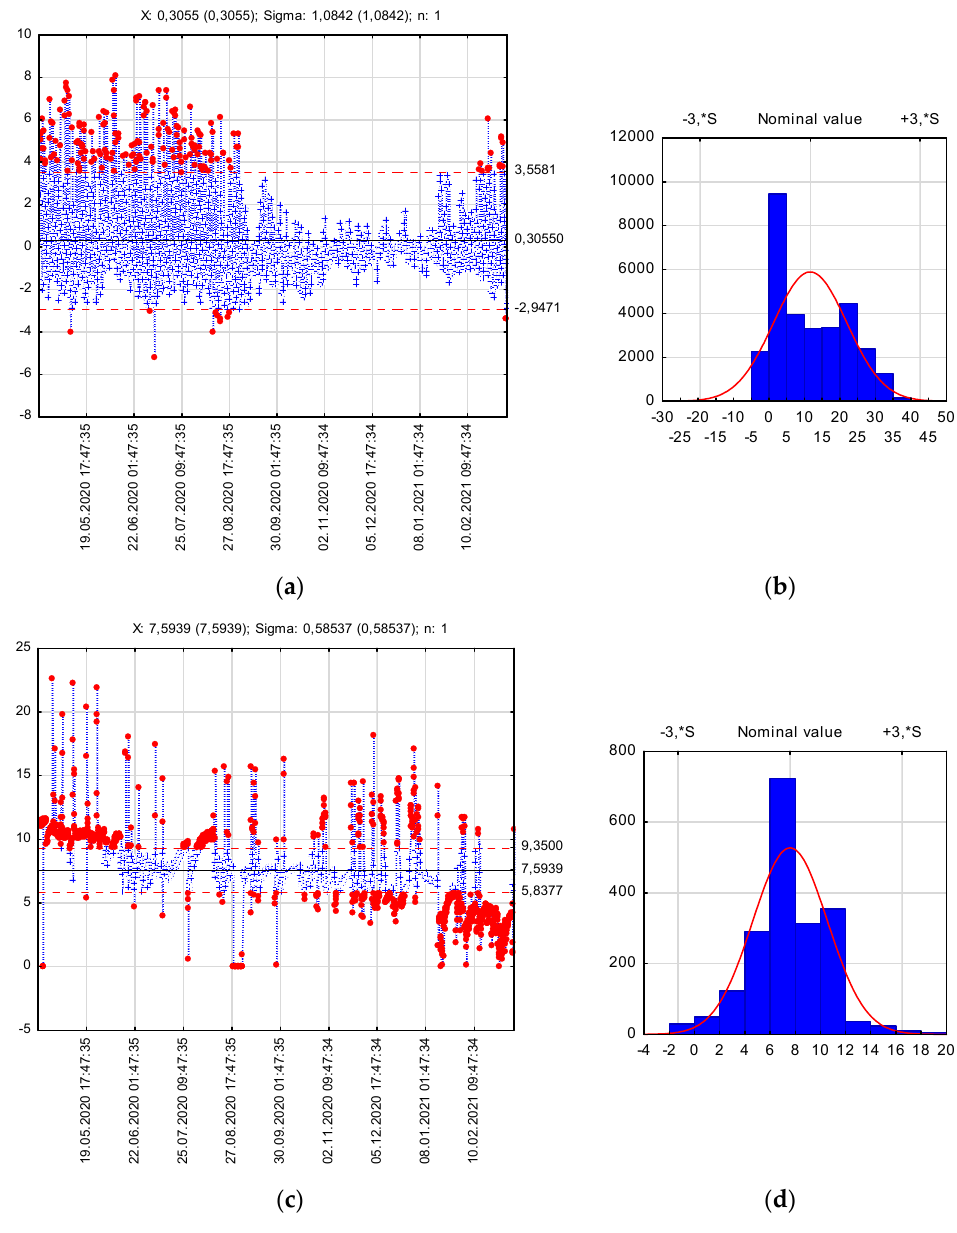
Figure 8. Shewhart charts for monitoring data forecast: ( a ) temperature MSE moving range; ( b ) temperature probability range; ( c ) humidity difference between the top and bottom surface of the CRM-FB_5C layer; ( d ) probability range for humidity difference between the top and bottom surface of the CRM-FB_5C layer.